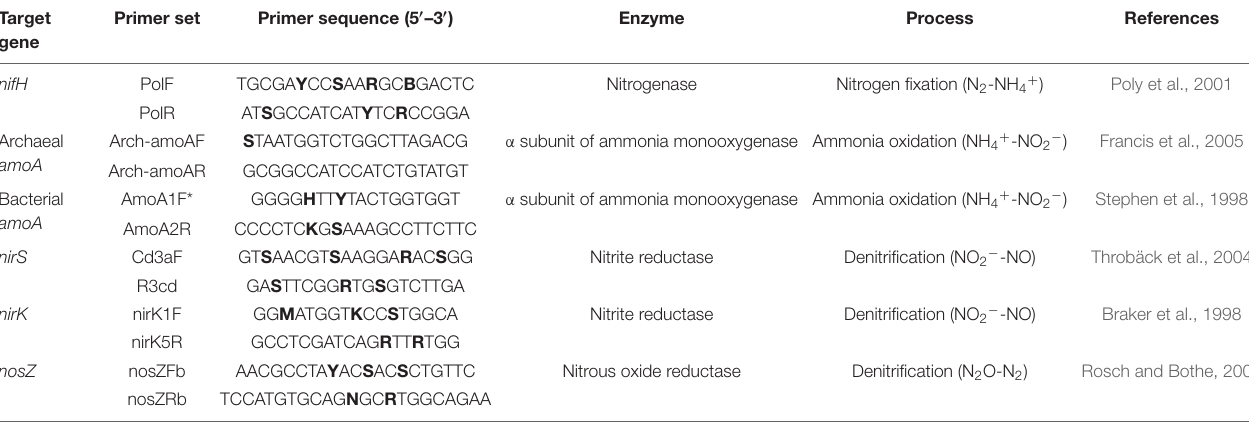
TABLE 2 | Summary of the genes investigated, the enzymes they encoded, and their functions in the nitrogen cycle. Target Primer gene